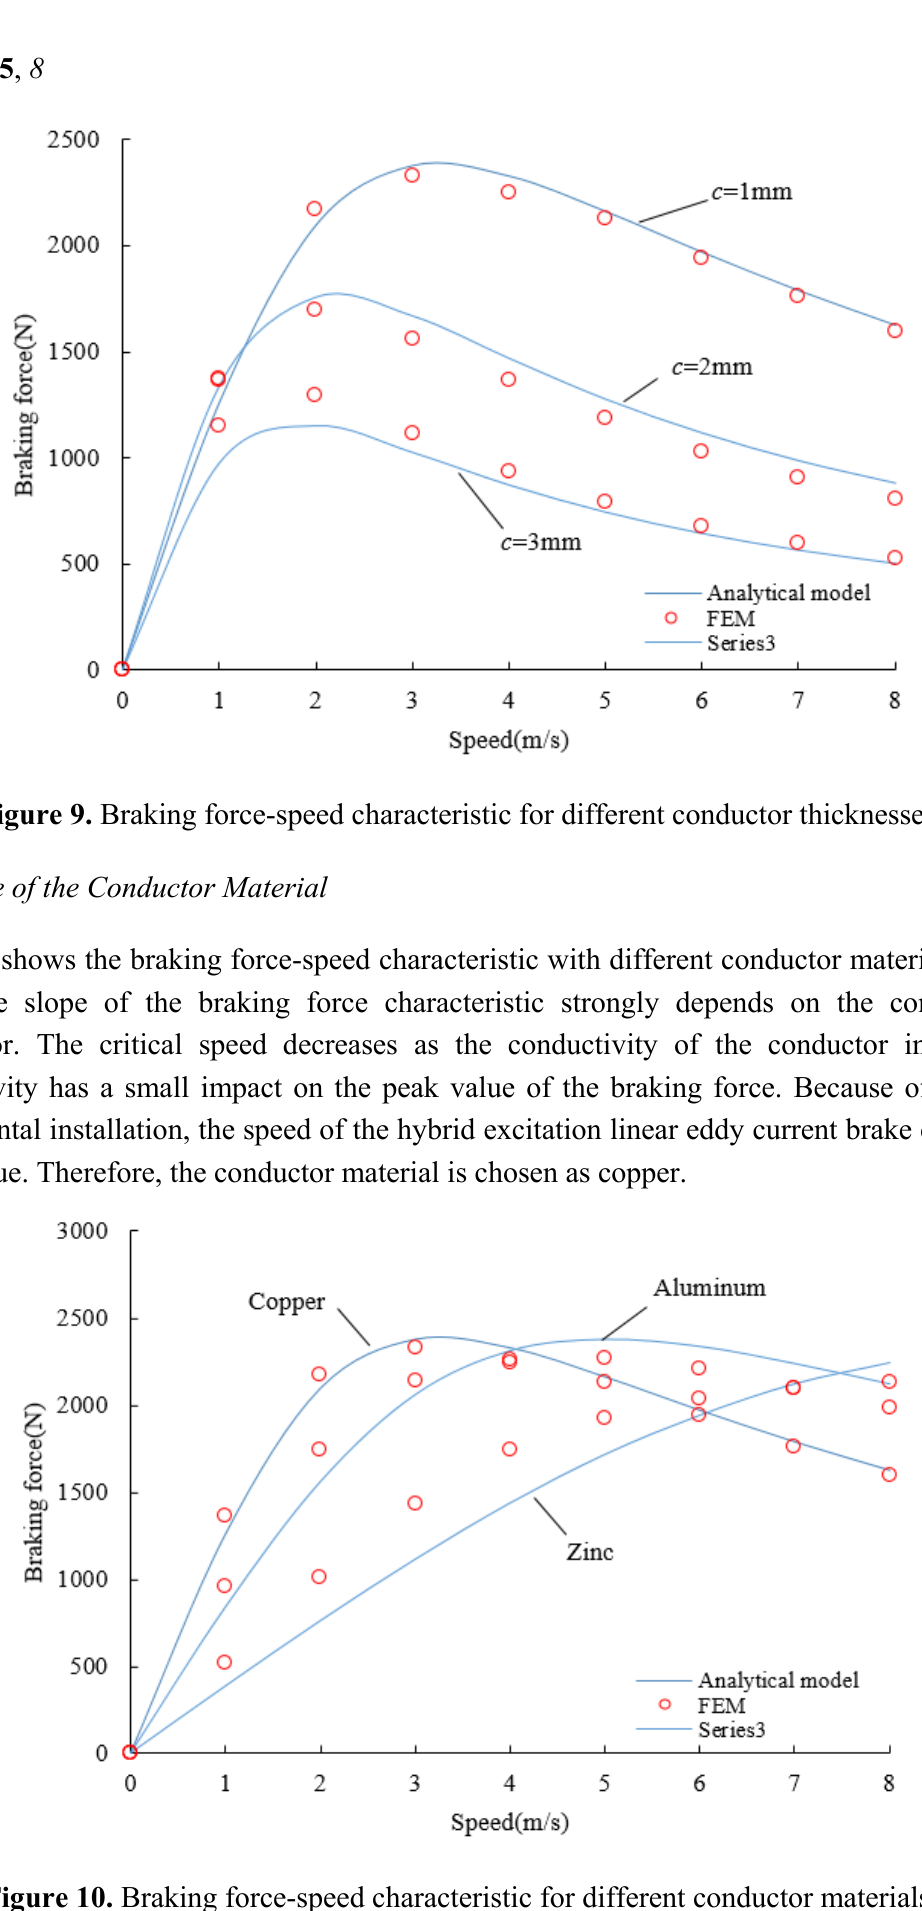
Figure 10. Braking force-speed characteristic for different conductor